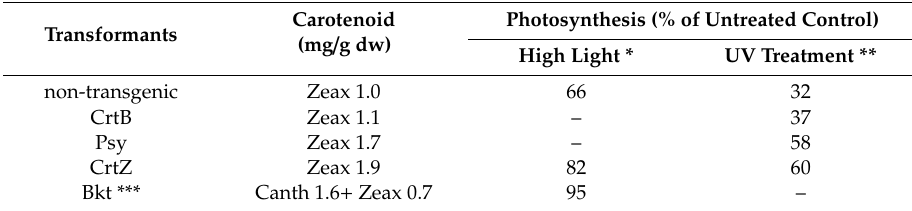
Table 1. Protection of photosynthetic oxygen evolution in Synechoccocus transformants with increased zeaxanthin or canthaxanthin content after exposure to high light or UV-B [55,56]. Carotenoid Photosynthesis (% of Untreated Control) Transformants (mg / g dw) High Light * UV Treatment ** non-transgenic Zeax 1.0 66 32 CrtB Zeax 1.1 – 37 Psy Zeax 1.7 – 58 Zeax 1.9 82 60 Canth 1.6 + Zeax 0.7